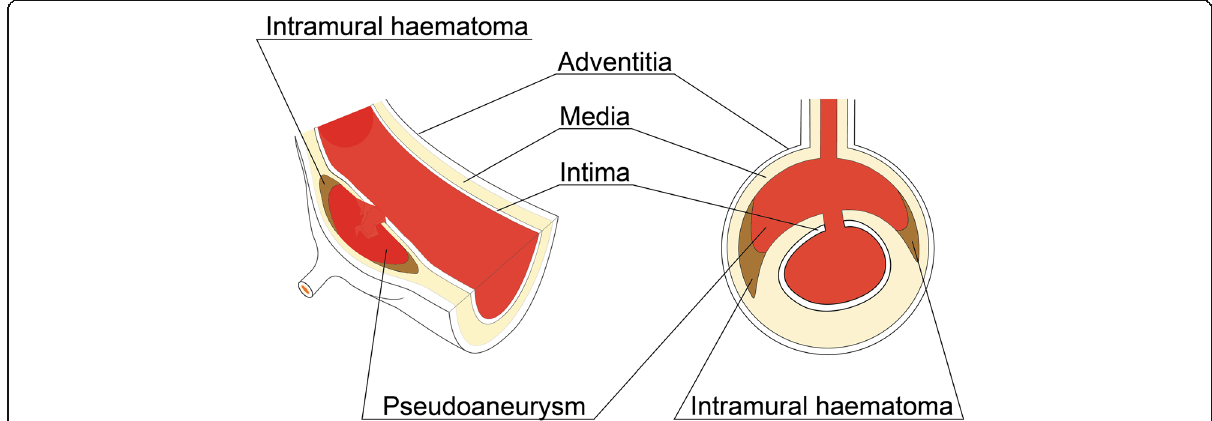
Fig. 1 Diagram showing the mixed aortic injury (grade II and III) in two different perspectives. This lesion is characterized by a disruption of the